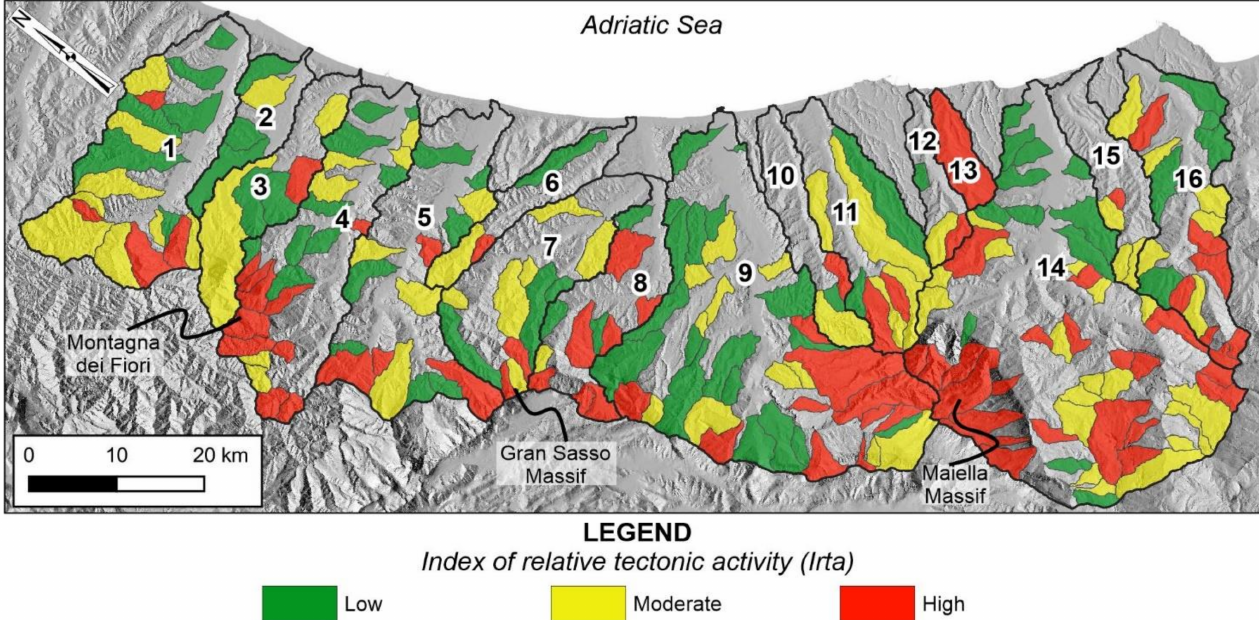
Figure 4. Index of Relative Tectonic Activity (Irta) map. Black lines represent the watershed of the main 16 basins analyzed. Numbers refer to the basins in Table